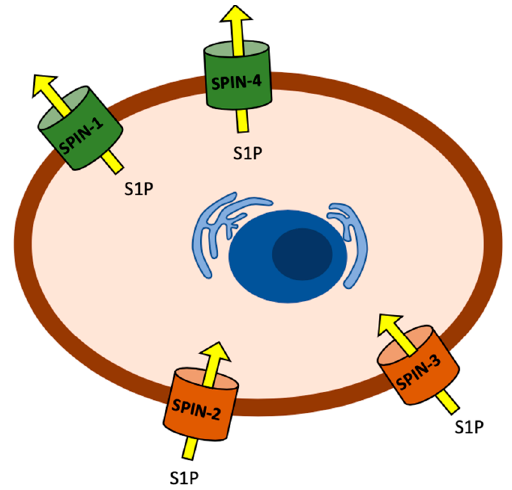
Figure 8. Model of S1P transporters directionality in C. elegans. SPIN-1 and SPIN-4 show canonical directionality transporting S1P out into the extracellular space. Mutations in these transports increases cytosolic S1P. SPIN-2 and SPIN-3 pump S1P into the cytosolic space. Mutations in both these transports decreases cytosolic S1P.